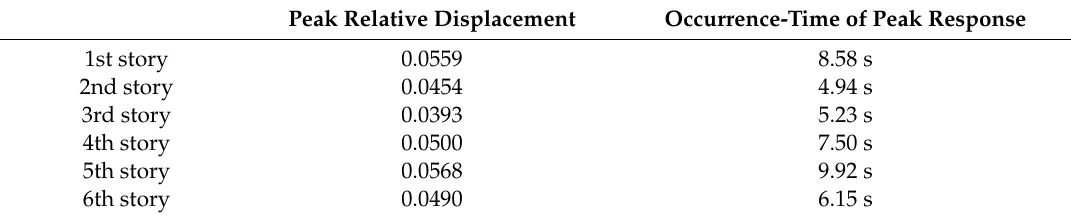
Table 1. Calculated peak relative displacements and occurrence-times without considering damage.